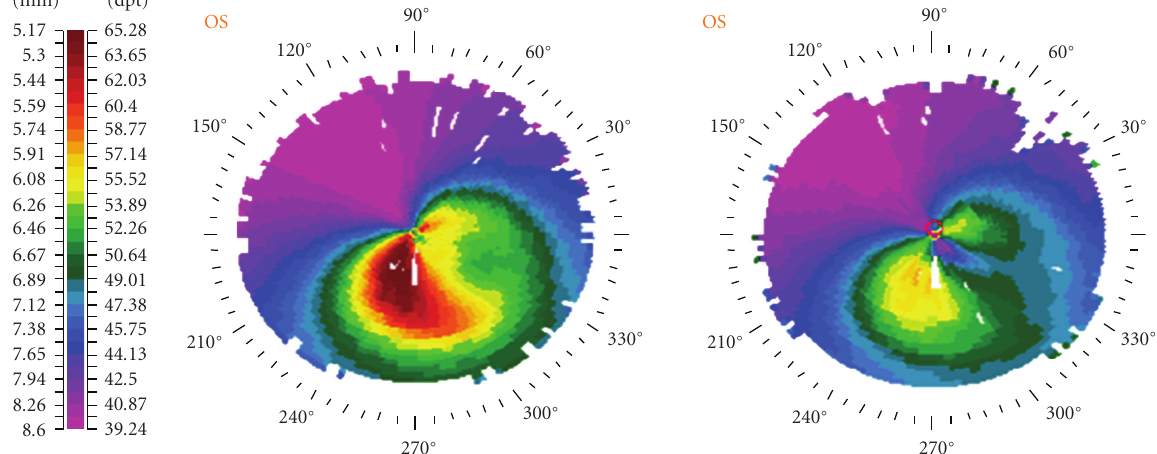
68 . 8 . Figure 2: Preoperative (left) and one-month postoperative (right) topography (Technomed C-Scan, Baesweiler, Germany) of the keratoconic patient treated with combined transepithelial phototherapeutic keratectomy and collagen cross-linking with riboflavin and UVA